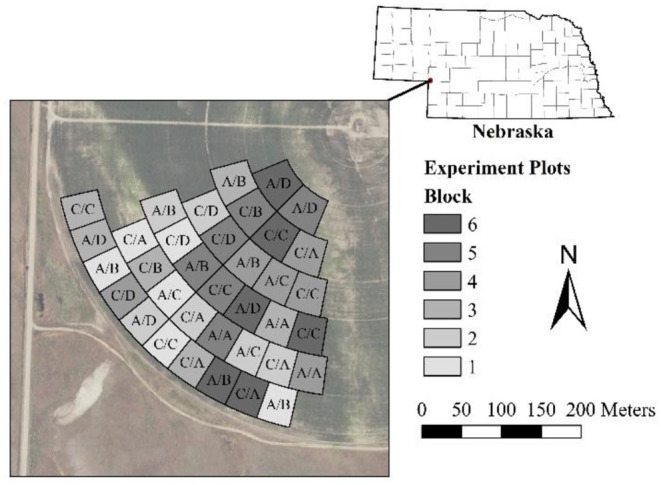
Experimental study area. Letters in plots are treatments (2017/2018). Treatments are: (A) VRI-Full, (B) VRI-Deficit, (C) Uniform-Full, and (D) Uniform-Deficit. Image source: USDA (2016). Political Boundaries sources: USDA (2009a,b).